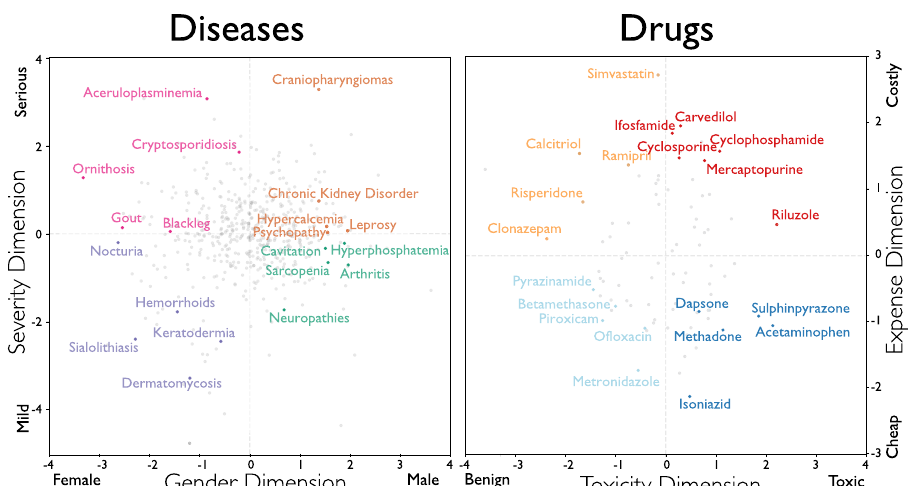
Fig. 4 Two-dimensional projections of diseases and medications. Left We projected diseases into two dimensions: female-male (X-axis) and severe-mild (Y-axis). We de fi ned the “ male – female ” axis using the following pairs of terms: ( “ male, ” “ female ” ), ( “ prostate, ” “ ovary ” ), ( “ penile, ” “ uterine ” ), ( “ penis, ’’ “ uterus ” ), ( “ man, ” “ woman ” ), ( “ men, ” “ women ” ), ( “ masculine, ” “ feminine ” ), ( “ he, “ “ she ” ), ( “ him, ” “ her ” ), ( “ his, ” “ hers ” ), ( “ boy, ” “ girl ” ), and ( “ boys, ” “ girls ” ). We de fi ned the severe-mild axis with the following term pairs: ( “ harmful, ” “ bene fi cial ” ), ( “ serious, ” “ benign ” ), ( “ life- altering, ” “ common “ ), ( “ disruptive, ” “ undisruptive ” ), ( “ dying, ’’ “ recovering ” ), ( “ dangerous, ” “ safe ” ), ( “ threatening, ” “ low-priority ” ), ( “ high mortality, ” “ harmless ” ), ( “ costly, ” “ cheap ” ), ( “ hospitalized, ” “ self-administered ” ), ( “ hospital, ” “ work ” ), ( “ debt, ” “ savings ” ), ( “ low quality of life, ” “ undisruptive ” ), and ( “ hazard, ” “ routine'). Right We projected medications into “ benign-toxic ” (X-axis) and “ cheap-costly ” (Y-axis). For the “ benign-toxic ” axis, we used the following pairs of antonym words: ( “ harmful, ” “ bene fi cial ” ), ( “ toxic, ” “ nontoxic ” ), and ( “ noxious, ” “ benign ” ). We de fi ned the “ expensive – inexpensive ” dimension using the following pairs of terms: ( “ expensive, ” “ inexpensive “ ), ( “ costly, ” “ cheap ” ), ( “ brand, ” “ generic ” ), and ( “ patented, ” “ off-patent ”